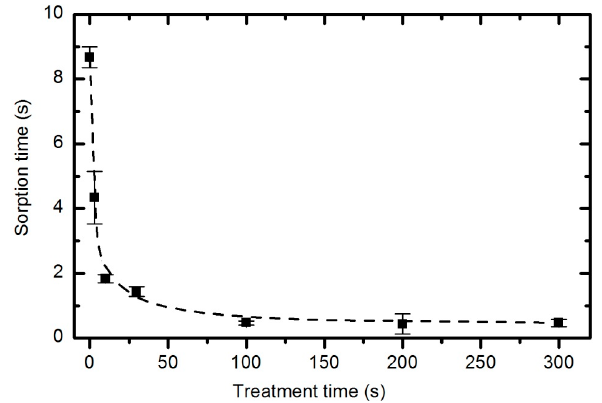
Figure 20. Absorption time of a water droplet versus plasma treatment time at 33 Pa and 150 W.